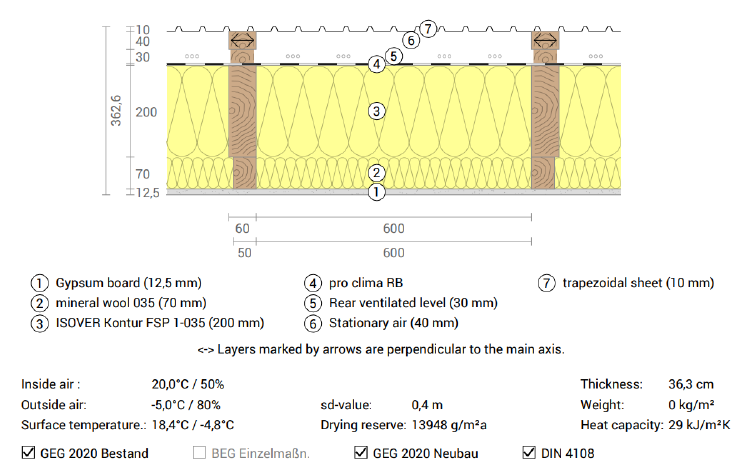
Figure 25. Cross section of a roof structure in a frame building.